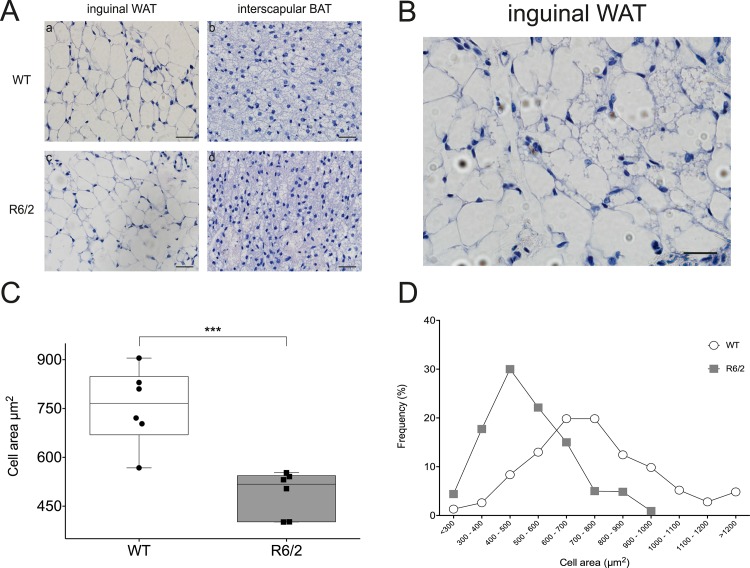
Brown-like adipose features within WAT in R6/2 mice.A Representative images of inguinal white adipose tissue (WAT) and interscapular brown adipose tissue (iBAT) from wild type (WT) and R6/2 transgenic mice. Scale bars = 20 μm. WAT is comprised of white adipocytes whose primary function is energy storage. As can be seen in subpanels a and c, white adipocytes are unilocular, with each one containing a single large lipid droplet that fills the cell. BAT is comprised of brown adipocytes and plays a role in energy metabolism and non-shivering thermogenesis in mammals. As shown in subpanels b and d, brown adipocytes are smaller than white adipocytes, multilocular, and rich in mitochondria. B Representative image from R6/2 inguinal WAT showing signs of small brown-like adipocytes within the tissue. Numerous regions of multilocular adipocytes, reminiscent of brown adipocytes observed in panel A, subpanels b and d, can be found interspersed between large unilocular white adipocytes. Scale bar = 20 μm. C Boxplot depicting mean subcutaneous inguinal white adipocyte areas from R6/2 mice (grey) and wild type (WT; white) littermates, n = 6/group, 100 cells/mouse measured. R6/2 mice have significantly smaller inguinal adipocytes than wild type littermates. Circles represent mean cell size for each WT mouse while squares represent mean cell size for each R6/2 mouse. Data presented as mean ± SEM. *** P < 0,001. D Cell areas were measured using cellSens software, based on 100 cells per mouse (n = 6/group). Data shows cell size distribution for inguinal WAT of the R6/2 and WT mice. WT mice tend to have a greater quantity of large (> 800 μm2) with only a low quantity of small adipocytes (< 300 μm2), while the converse is true for R6/2 mice. White circles represent WT mice while grey squares represent R6/2 mice.